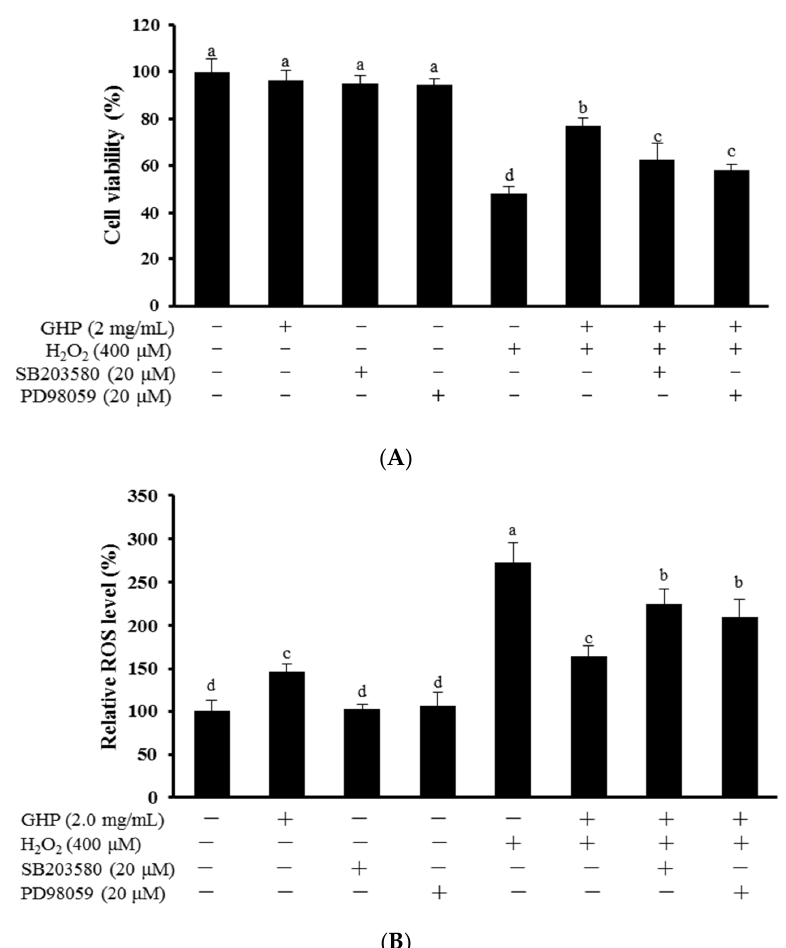
Figure 6. Roles of ERK1/2 and p38 MAPK in GHP ‐ mediated cytoprotection against H 2 O 2 ‐ induced oxidative damage in HepG2 cells. ( A ) Cells were pretreated with PD98059 or SB203580 (20 μ M) for 2 h and then incubated with GHP (2.0 mg/mL), or not, for 12 h, followed by stimulation with H 2 O 2 for 6 h. Cell viability was measured using MTT assay; ( B ) Cells were pretreated with either PD98059 or SB203580 each at a concentration of 20 μ M for 2 h prior to incubation with GHP (2.0 mg/mL), or not, for additional 12 h, and then stimulated with H 2 O 2 for 30 min. The intracellular ROS levels were measured by DCF ‐ DA with fluorescent analysis. The results are presented as the means ± SD of four independent experiments. Means with different letters are significantly different from each other at p < 0.05.